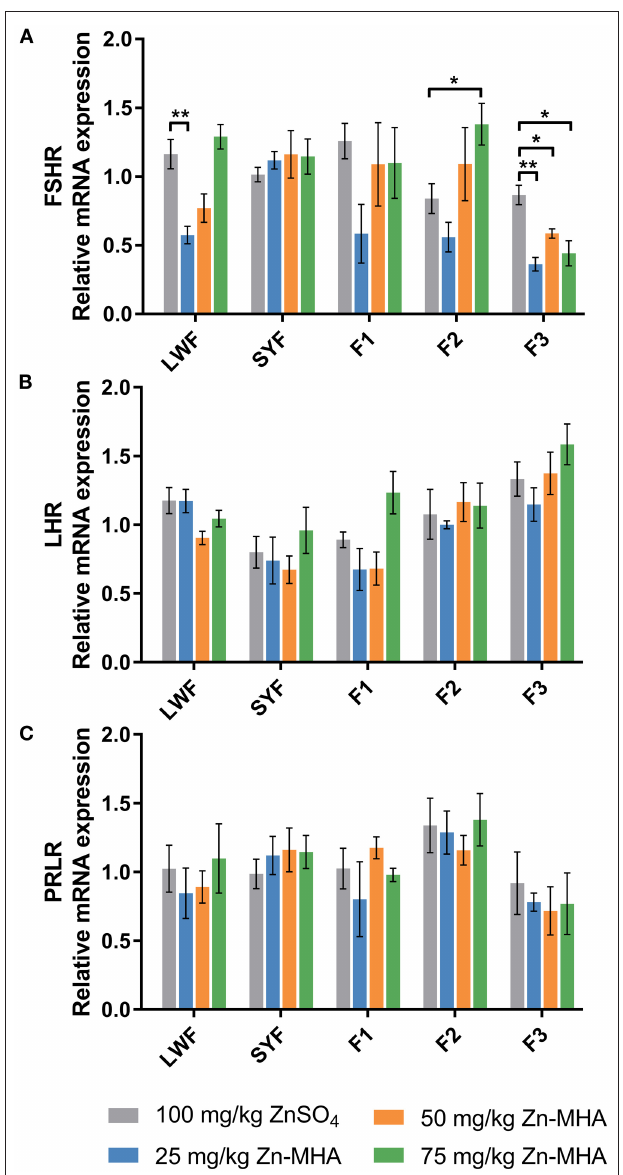
FIGURE 1 | Effects of dietary Zn-MHA supplementation on the mRNA relative expressions of reproductive axis genes in broiler breeders. SYF, small yellow follicles (4 to 10mm in diameter). LWF, large white follicles (2 to 4mm in diameter). F1, the first largest one of preovulatory follicles. F2, the second largest one of preovulatory follicles. F3, the third largest one of preovulatory follicles. FSHR , follicle-stimulating hormone receptor; LHR , luteinizing hormone receptor; PRLR , prolactin receptor. (A–C) Data represent mean values of 3 hens each treatment as mean ± SEM. * refers to P < 0.05 and ** refers to P < 0.01 between the control and experimental groups by independent-sample t